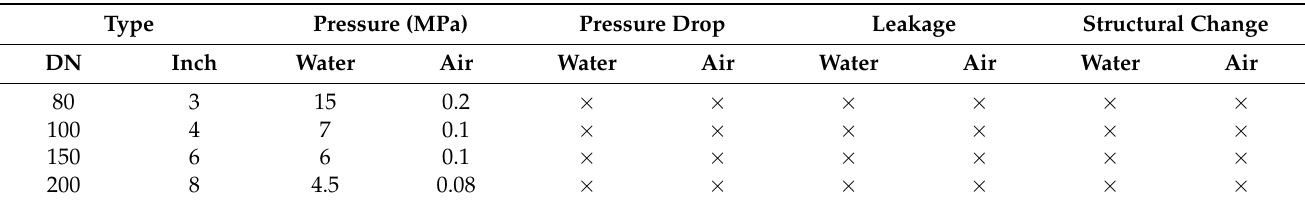
Table 3. Typical results of the working pressure test.